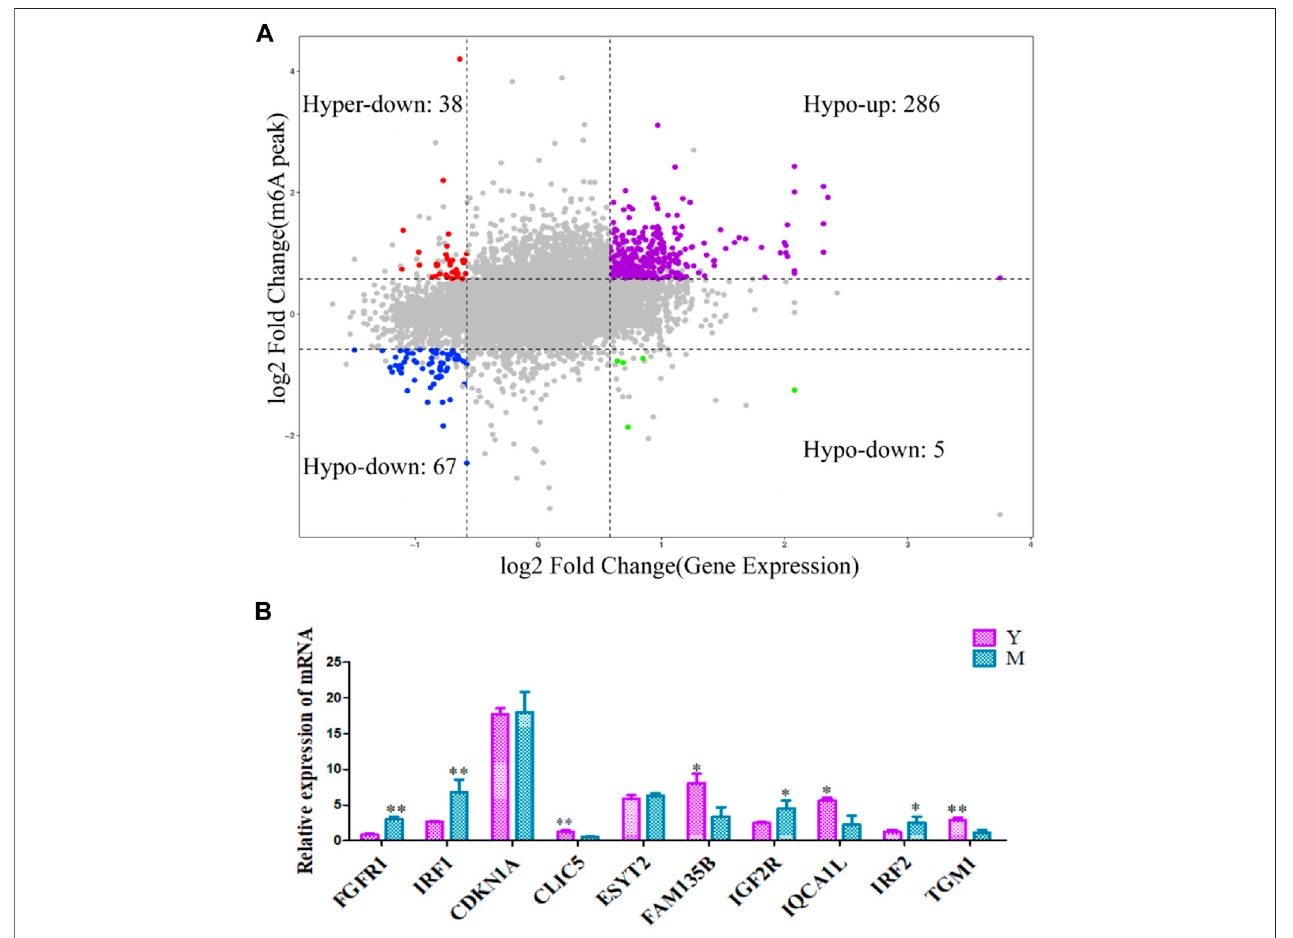
FIGURE6| Differentiallymethylatedand expressed genesexaminedusing conjointanalysisand veri fi ed usingqRT-PCR. (A) Combined four-quadrantscatter plot ofgenesshowingdifferentialmethylationanddifferentialexpression(graydots,geneswithnosigni fi cantdifferences;coloreddots,geneswithsigni fi cantdifferences). (B) The differentially expressed genes were veri fi ed using qRT-PCR. Y: before sexual maturation. M: after sexual maturation. ** p < 0.01, * p < 0.05.